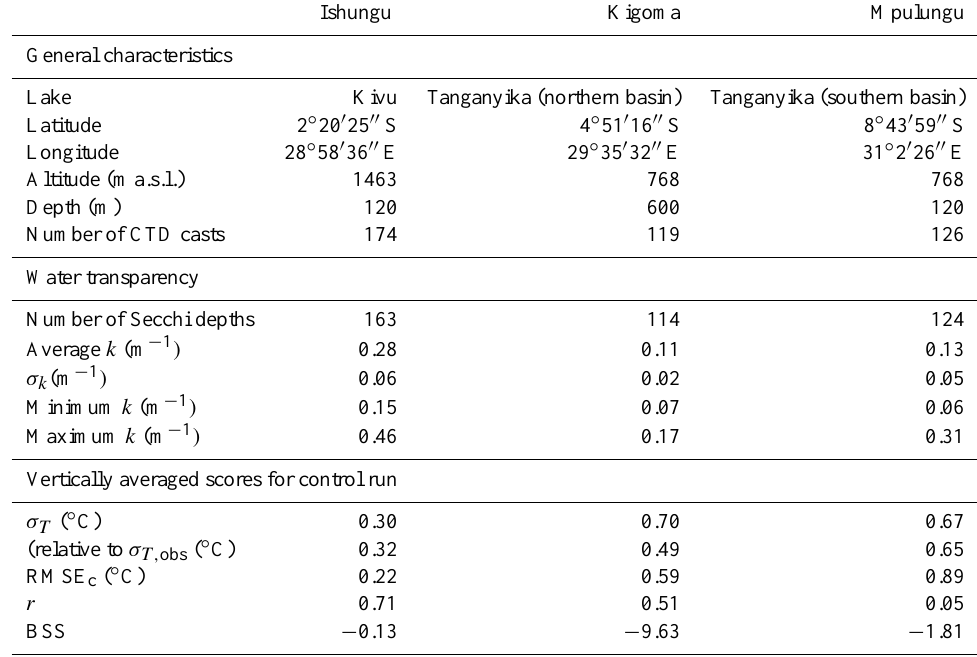
Table 2. Characteristics of the model evaluation sites. Water transparency characteristics are the downward light attenuation coefficient k (m − 1 ) and its standard deviation σ k (m − 1 ) . Control run scores are standard deviation σ T ( ◦ C), centred root mean square error (RMSE c ) ( ◦ C), Pearson correlation coefficient r and Brier Skill Score